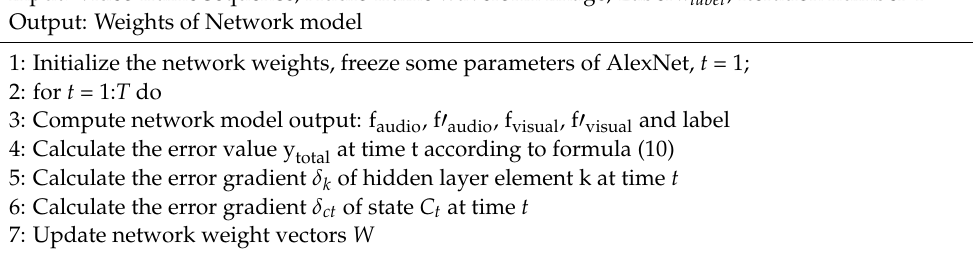
Algorithm 1. Algorithm of Auditory Visual Fusion of Autoencoder